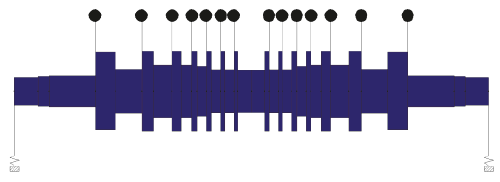
(d) The cross stiffness coefficients 𝐶 𝑥𝑦 and 𝐶 𝑦𝑥 Figure 15: Comparison of bearing dynamic coefficients.